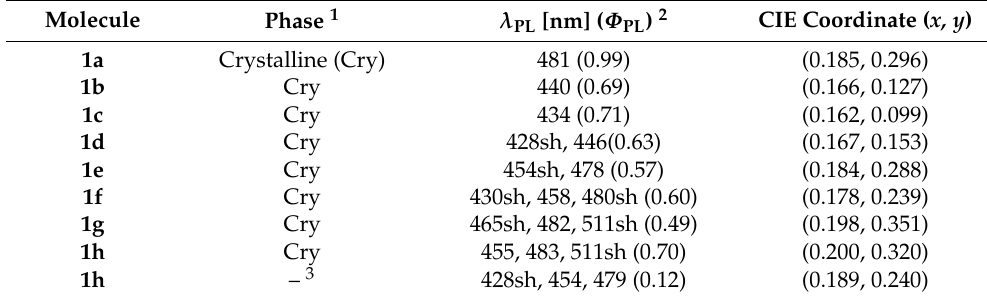
Figure 7. ( a ) PL spectra of 1a – h in crystalline state. Excitation wavelength ( λ ex ): 300 nm. Inset: Photographs of the PL behavior of the 1a – h crystals under UV light ( λ ex = 365 nm). ( b ) CIE color diagram of PL colors for 1a – h crystals. Table 3. Photophysical data of 1a – h in aggregated phases.